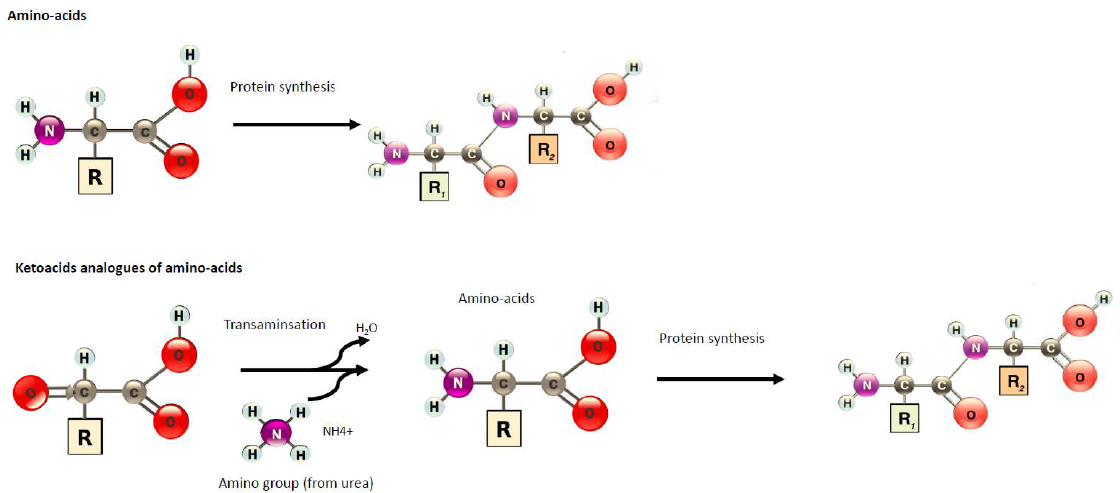
Figure 1. Amino-acid and transamination of ketoacid analogues of amino acids in order to synthesize protein.